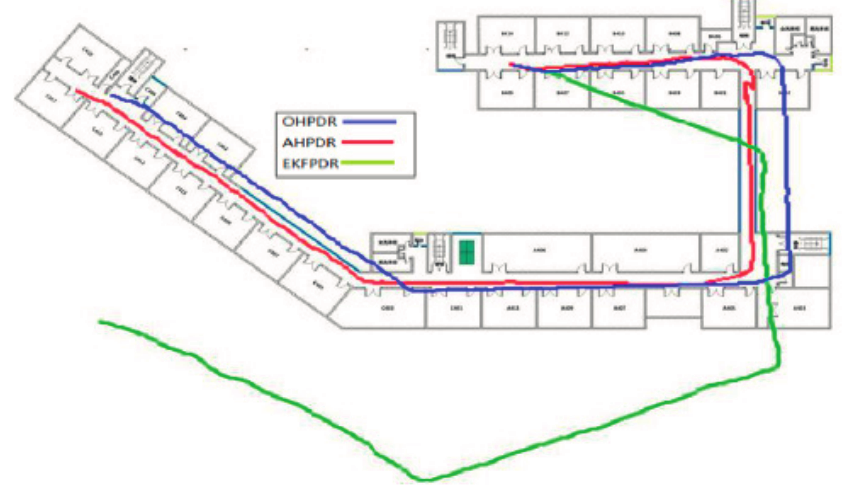
Figure 10. Positioning trajectory analysis for different solutions associated with PDR .